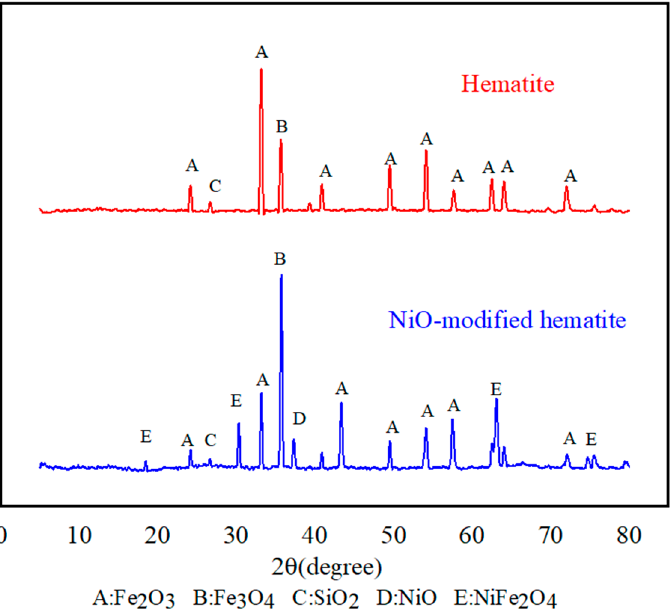
Figure 3. The XRD patterns of the pristine hematite and the NiO-modified hematite. The gas yield results for the individual gases of the wood waste gasification experi- ments using Al 2 O 3 , pristine hematite, and NiO-modified hematite are shown in Figure 4. The experiment was performed at a temperature of 850 ◦ C and a mass ratio of OC to wood waste (O/W) of 1.